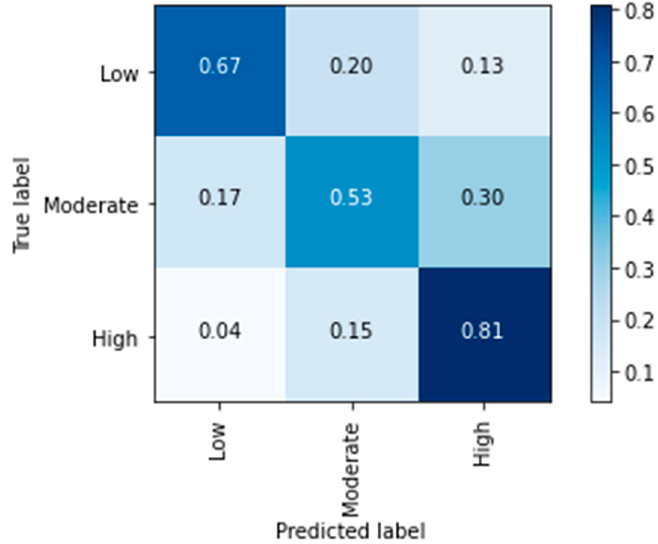
Figure 11. A representative sample confusion matrix.